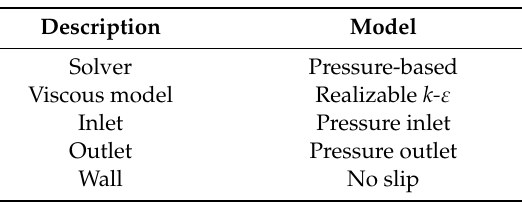
Figure 1. Simulation models: ( a ) conventional hopper; ( b ) spiral hopper. Table 1. CFD model description.